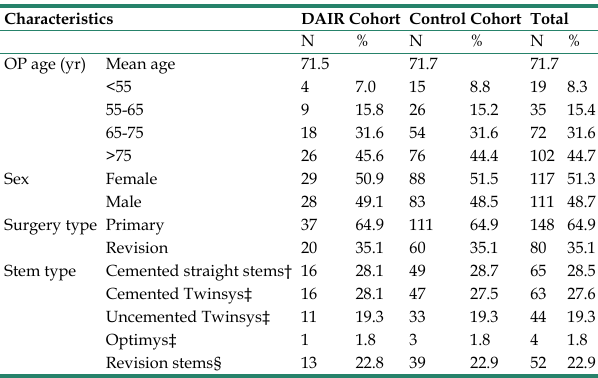
Table 1. Patient characteristics and THA-associated variables in the study population*